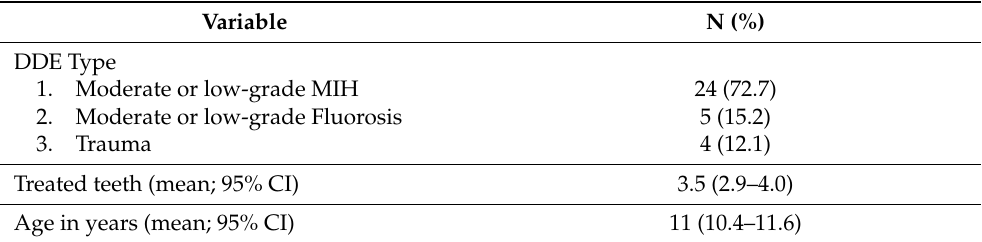
Table 1. Descriptive statistics. Absolute frequencies and percentages are for total sample if not otherwise indicated.